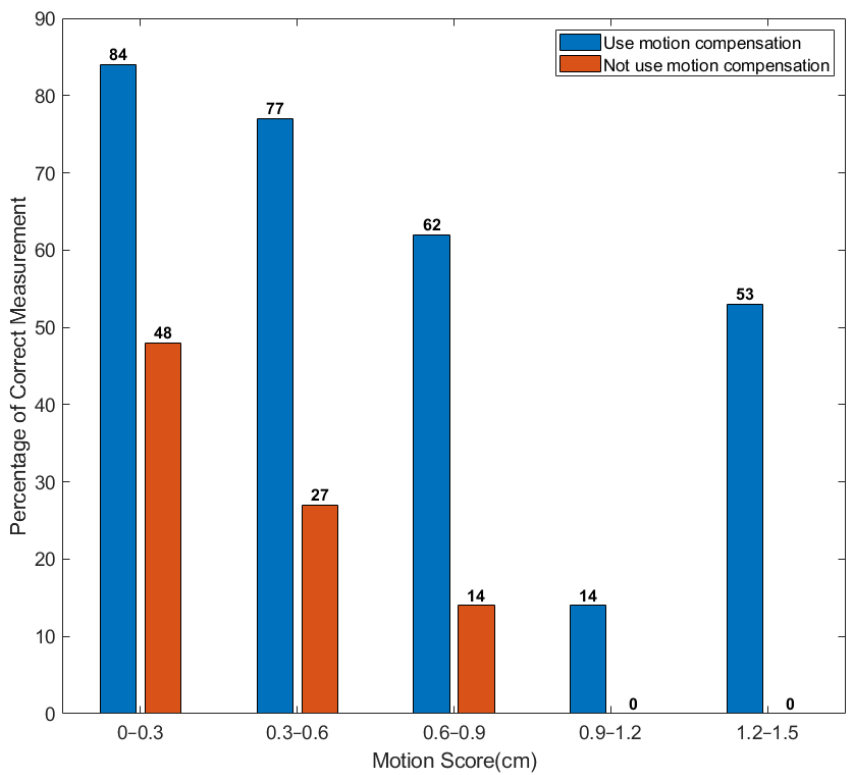
Figure 13. Percentage of correct HR measurement within each motion score